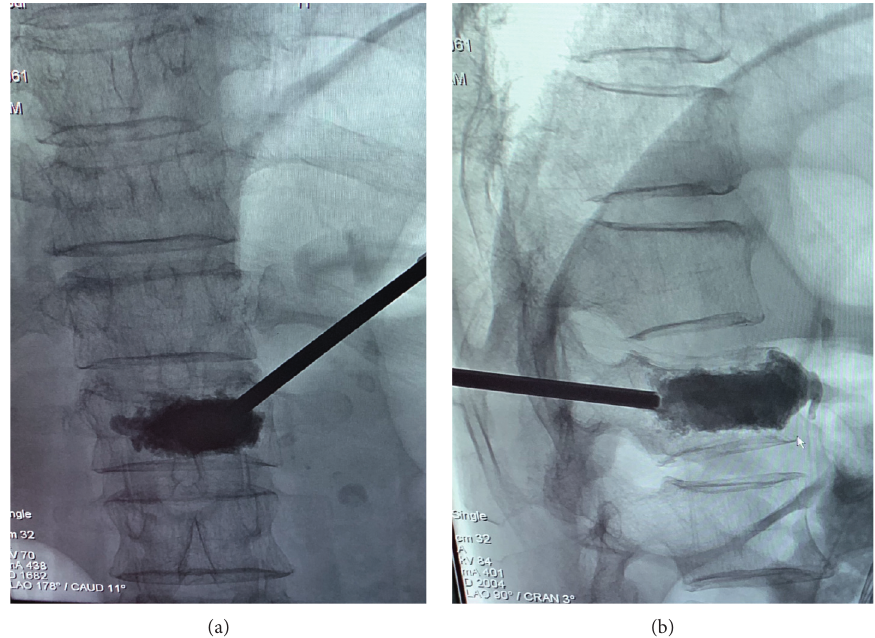
Figure 1: Male patient with back pain due to osteoporotic fracture of the L1 vertebral body. The frontal and the lateral fluoroscopy view—needles were placed in the anterior third of L1 vertebral bodies and cement injection was finished under continuous